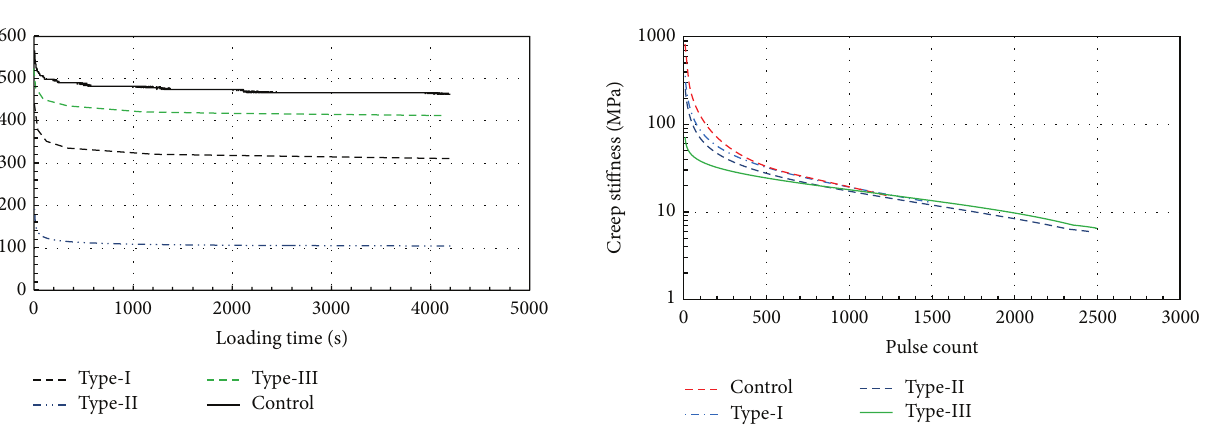
Figure8:Variationincreepstiffnesswithrespecttorubbertypeand pulse